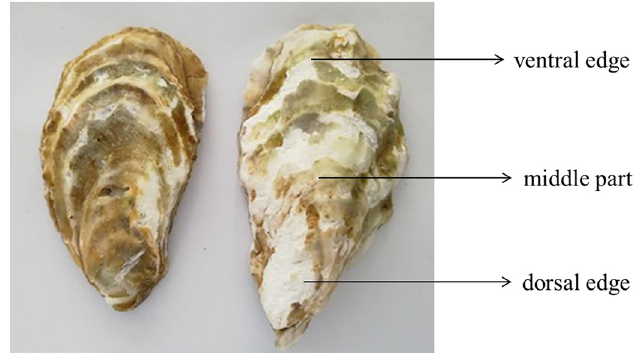
Fig. 1. Sampling sites of the dorsal, middle, and ventral edges of C. gigas